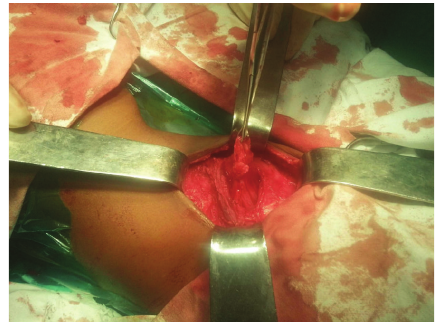
Figure 5: Defect in the attenuated musculature with the sac dissected up to the neck.